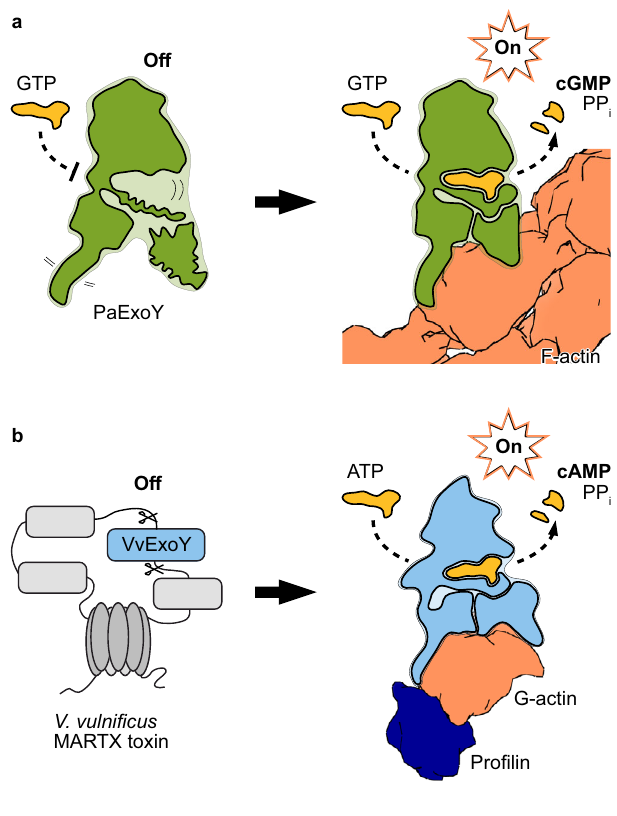
Fig. 5 Activation of the actin-dependent nucleotidyl cyclase toxins. a Formation of the PaExoY-F-actin complex results in an allosteric stabilization of the nucleotide binding pocket of PaExoY and thereby to an activation of the enzyme. b VvExoY is a module of MARTX toxins from V. vulni fi cus . After proteolytic cleavage, this module interacts with the G-actin- pro fi lin complex and becomes a potent nucleotidyl cyclase. PPi inorganic